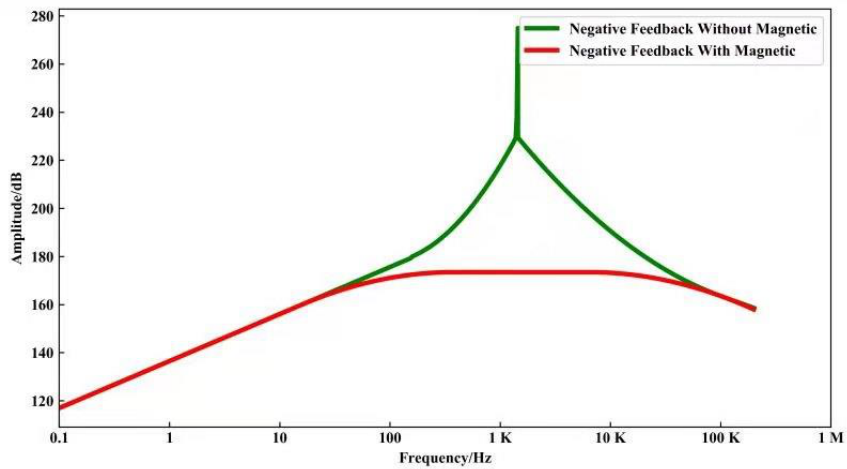
Figure 5. The simulation curve of the amplitude – frequency characteristic.